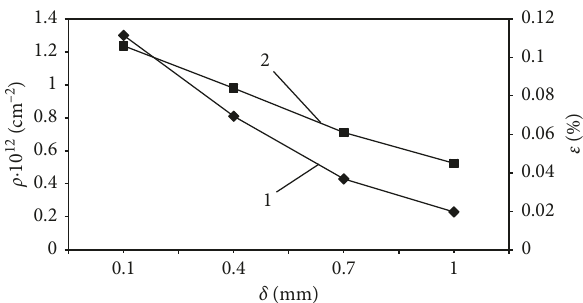
Figure 4: Changes of dislocation density (1) and relative de- formation of the lattice (2) along a depth δ of the strengthened layer.